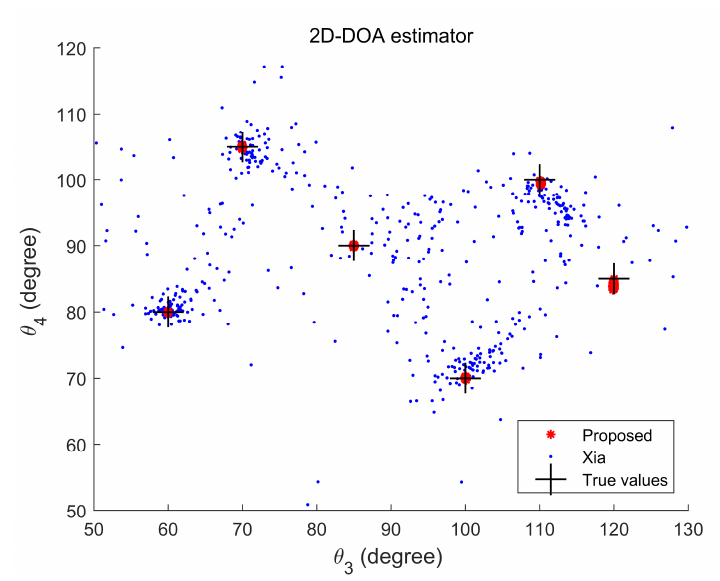
Figure 5. 2D-DOA scattergram of six mixed signals.